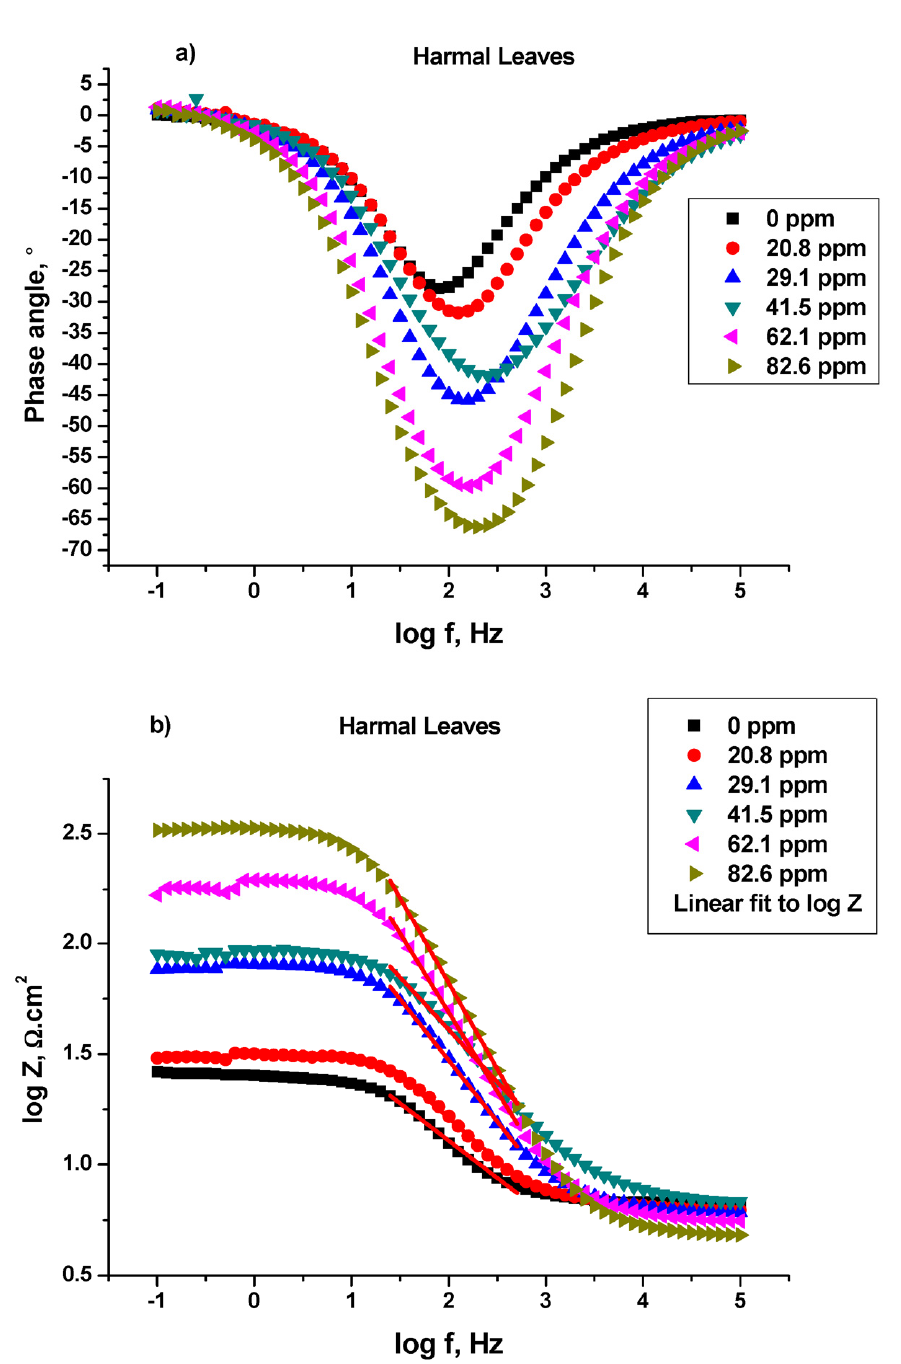
Figure 7. Bode phase ( a ) and Bode ( b ) plots of a C-steel electrode in 0.25 M H 2 SO 4 solution with and without different concentrations of leaf extract.